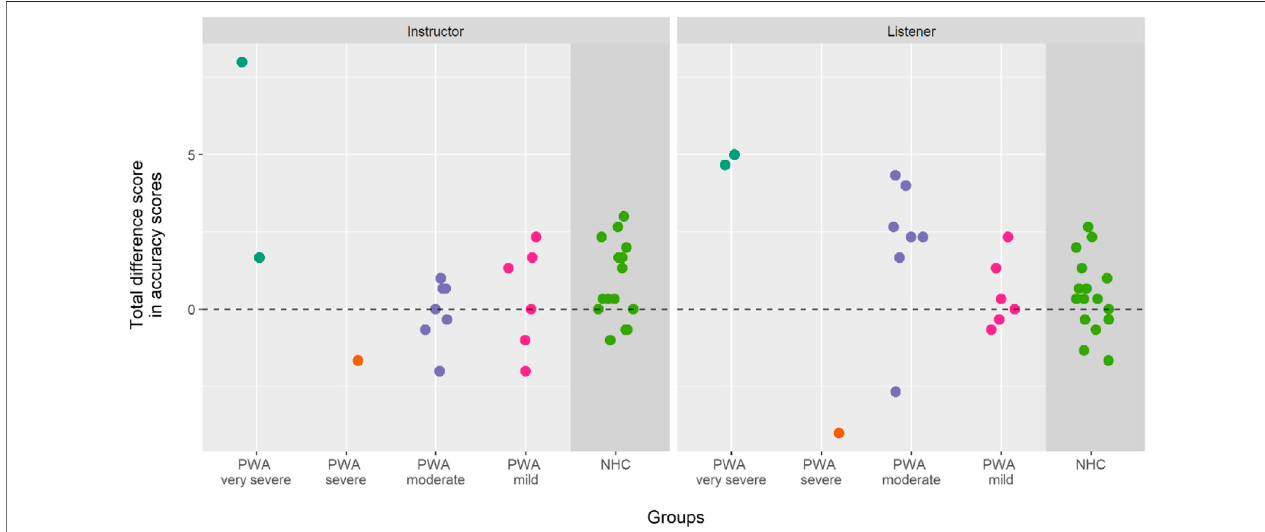
FIGURE6| PlotshowingindividualdatapointsforPWAfordifferencescorebetweenfamiliarandunfamiliarconditions,byrole,categorizedbyWABcategorization. Zero represents no change in accuracy scores between conditions, negative values indicate a lower accuracy score in the unfamiliar condition compared to the familiar